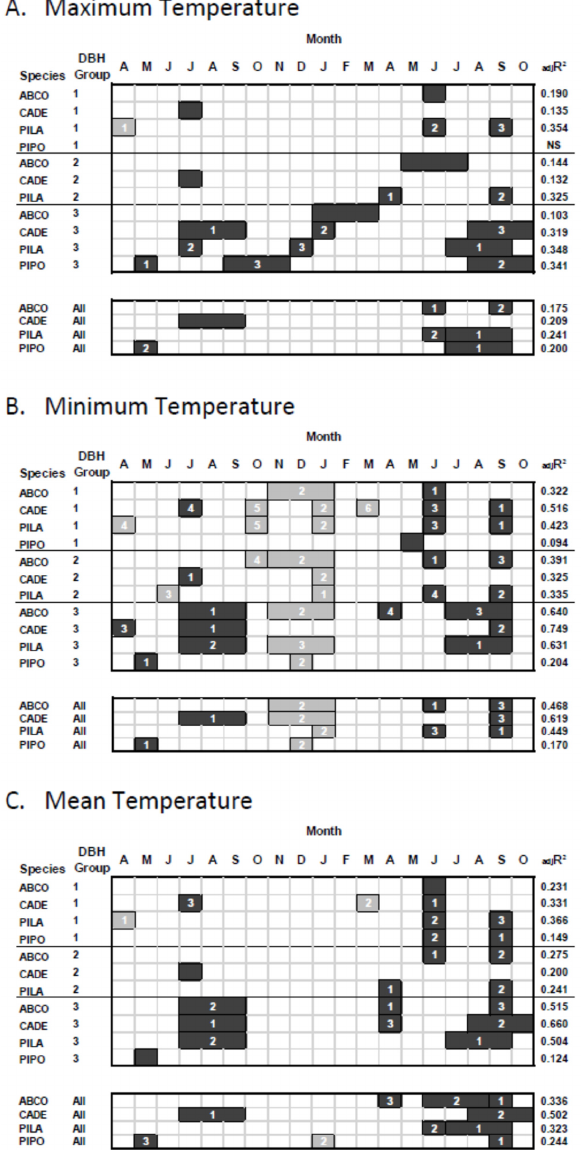
Figure 5. Statistically significant ( p < 0.05) growth responses to ( A – C ) by species and diameter group and for each species as a whole (i.e., with all diameter groups combined). Darker coloring indicates a negative correlation with growth, whereas lighter coloring indicates a positive correlation with growth. Numbers indicate the order of importance for that relationship, with 1 being the most important (according to the standardized partial regression coefficients). Explanatory climate variables expressed either for a monthly period or a 3-month seasonal period. NS = no significant variables in the model.